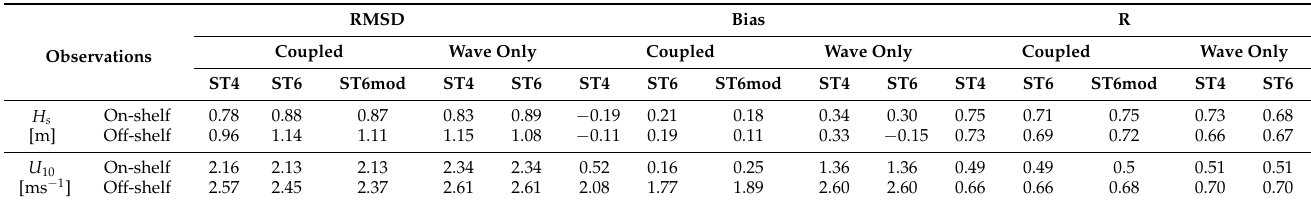
Table 5. On-shelf and off-shelf summary statistics (root-mean-square deviation (RMSD), bias and correlation coefficient (R)) for significant wave height ( H s ) and wind speed ( U 10 ) extremes, quantile of 90% (Q90%) for UKC4aow-ST4, UKC4aow-ST6, UKC4aow-ST6mod, UKW4h-ST4 and UKW4h-ST6 versus Q90 for JCOMM and SHPSYN observations over 2013-11-30 to 2014-02-28. The limit between on-shelf and off-shelf locations was the 200-m depth